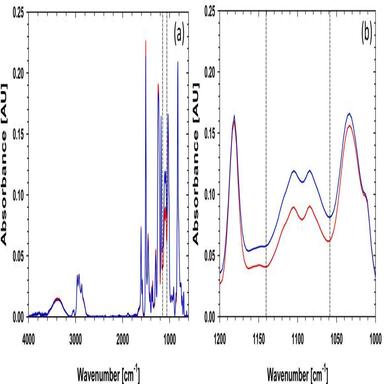
Surface spectra from two different points, with the highest (blue spectrum) and lowest (red spectrum) ether peak, of the printed coupon containing 2% nonylphenol (a) and the enlarged ether spectral region (b).The ether region is marked by dashed lines.